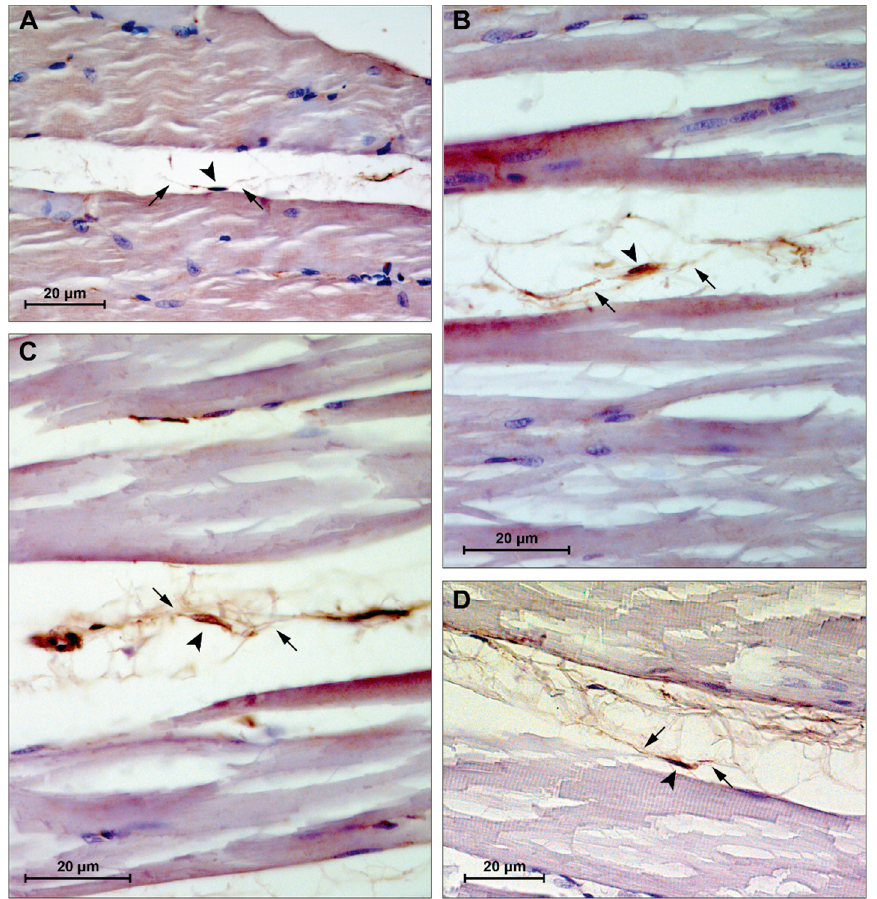
Figure 7. Representative images of immunohistochemistry staining for muscle tissue CD34+ cells. ( A ) group CTRL4W, estimated size body (arrowhead): 5.23 µ m, estimated cytoplasmic processes length (arrows): 13.28 and 24.28 µ m; ( B ) group PA4W, estimated size body (arrowhead): 5.04 µ m, estimated cytoplasmic processes length (arrows): 26.68 and 11.94 µ m; ( C ) group CTRL16W, estimated size body (arrowhead): 8.69 µ m, estimated cytoplasmic processes length (arrows): 13.07 and 20.56 µ m; ( D ) group PA16W, estimated size body (arrowhead): 9.56 µ m, estimated cytoplasmic processes length (arrows): 22.03 and 13.36 µ m. Lens magnification: × 40. Scale bars: 20 µ m. CD34+ cells nuclei and cytoplasmic processes were measured using a caliper tool of the software for image acquisition (AxioVision Release 4.8.2—SP2 Software, Carl Zeiss Microscopy GmbH, Jena, Germany). CTRL4W, control sedentary rats sacrificed at 4 weeks; PA4W, rats performing physical exercise sacrificed at 4 weeks; CTRL16W, control sedentary rats sacrificed at 16 weeks; PA16W, rats performing